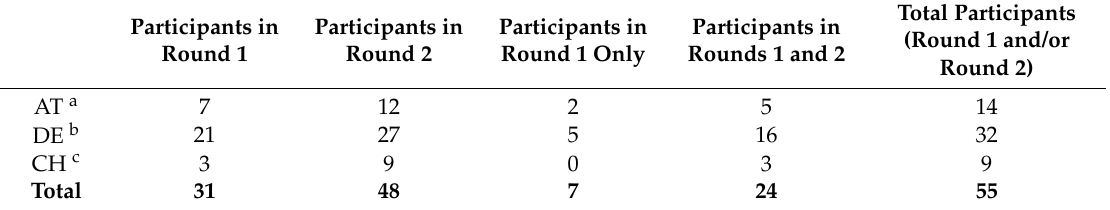
Table 2. Participants of the respective rounds of the Delphi